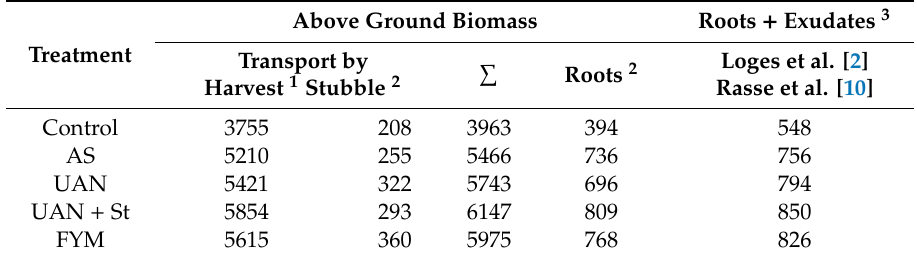
Table 1. Carbon balance of maize (kg C ha year − 1 ); AS–ammonium sulfate, UAN–urea ammonium